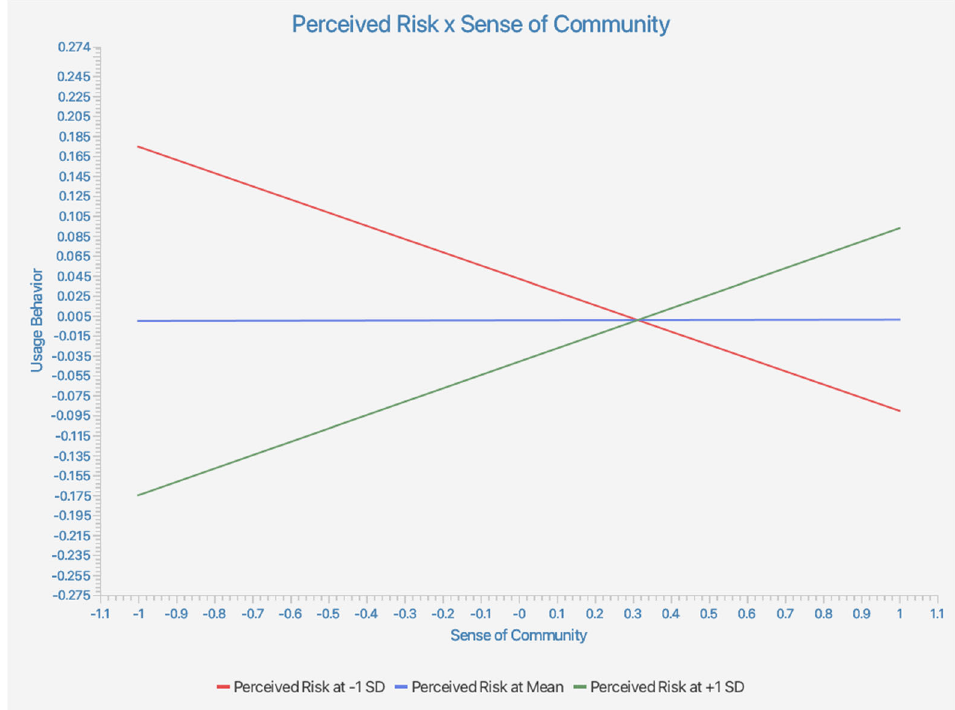
Figure 3. The moderating effect of perceived risk on the relationship between sense of community and usage behavior.